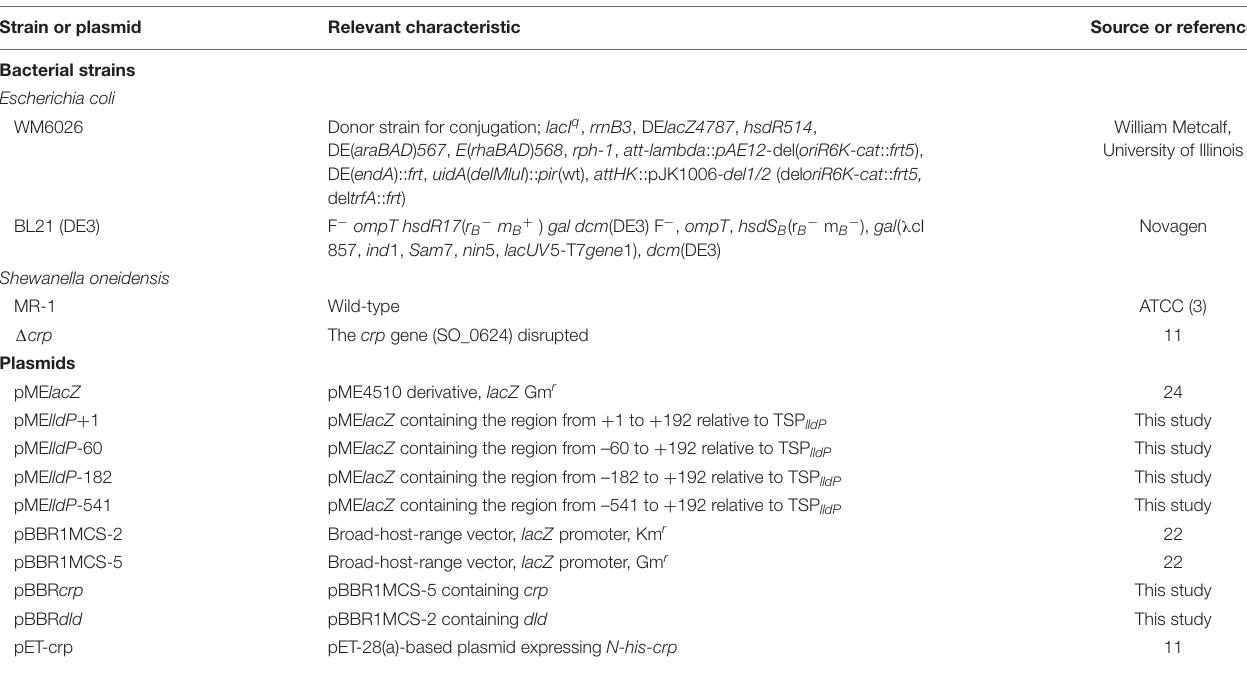
Table S1, and purified by gel electrophoresis using a QIAEX II Gel Extraction Kit (Qiagen) according to the manufacturer’s instructions. Standard curves were generated by amplifying a dilution series of the purified DNA fragments of each gene. The specificity of quantitative PCR was verified by a dissociation- curve analysis. Expression levels of target genes were normalized based on expression levels of the 16S rRNA gene.